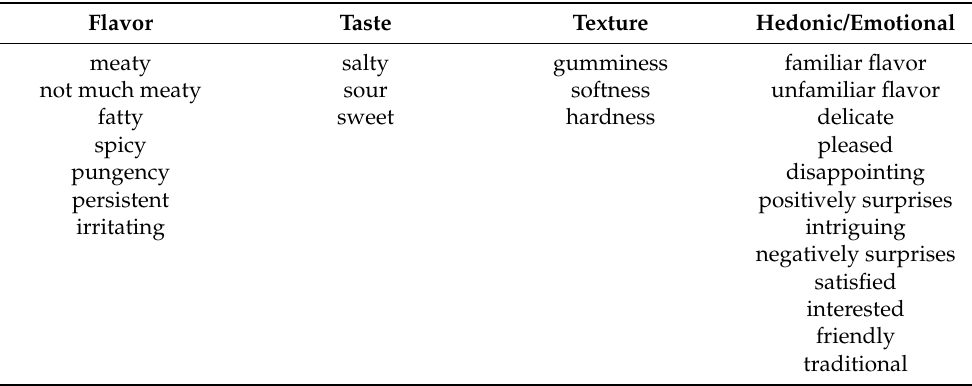
Table 1. Attributes used in check-all-that-apply (CATA) questionnaire for salami and pancetta